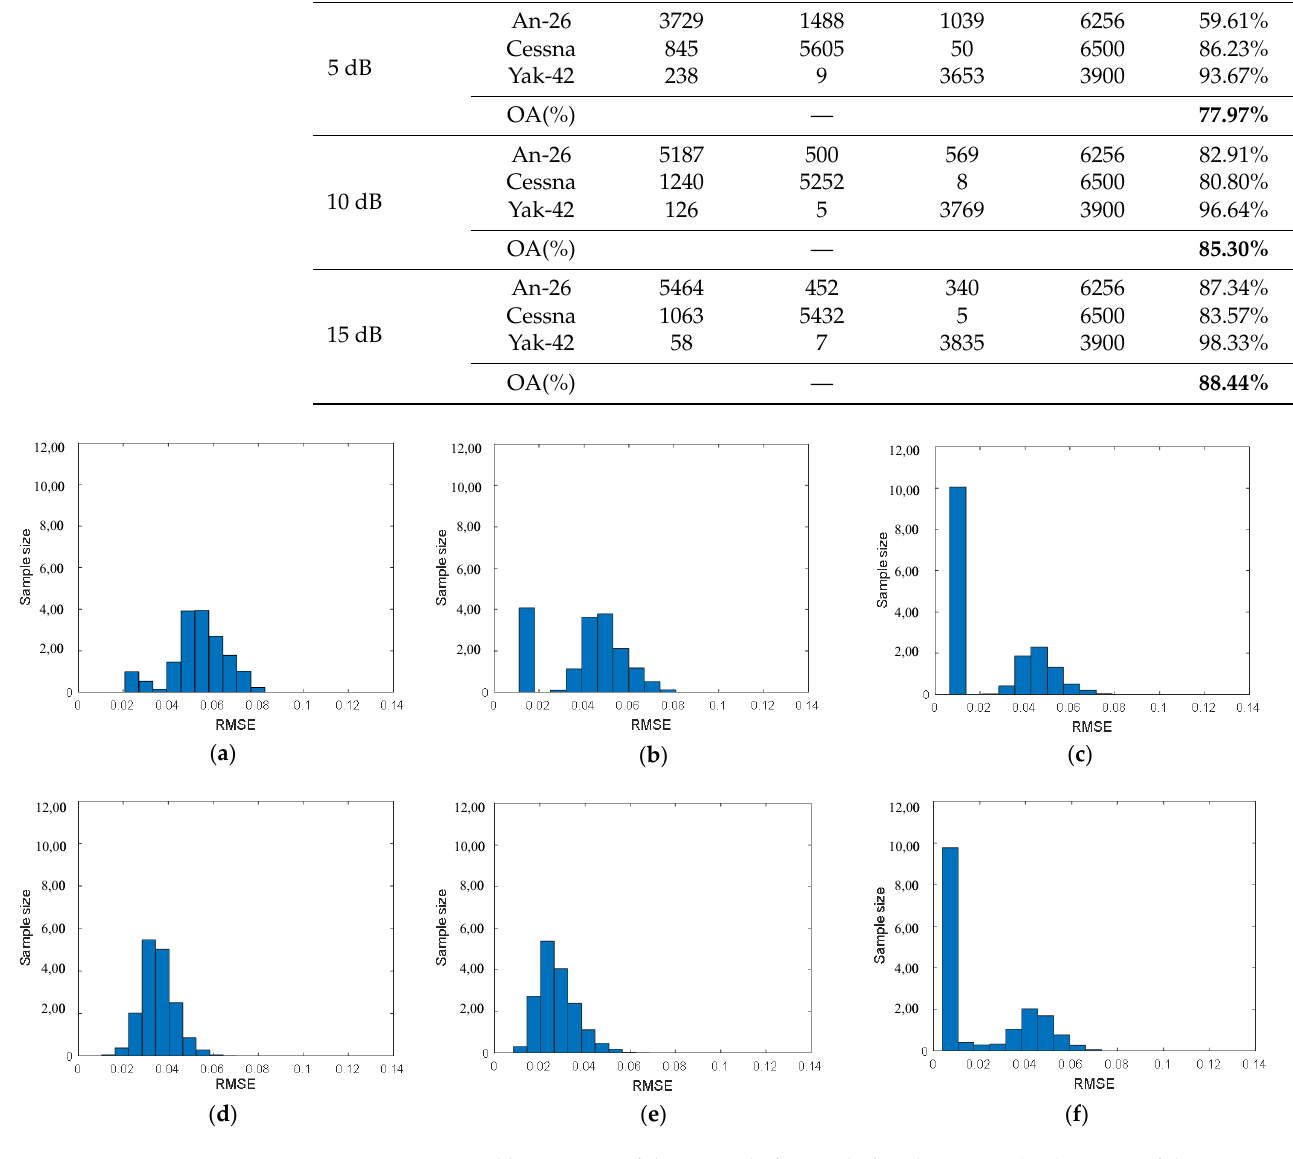
Figure 8. Statistical histograms of the RMSE before and after denoising. ( a – c ): RMSE of the noisy test samples for SNR of 5 dB, 10 dB, and 15 dB; ( d – f ): RMSE of the denoised samples for SNR of 5 dB, 10 dB, and 15 dB.